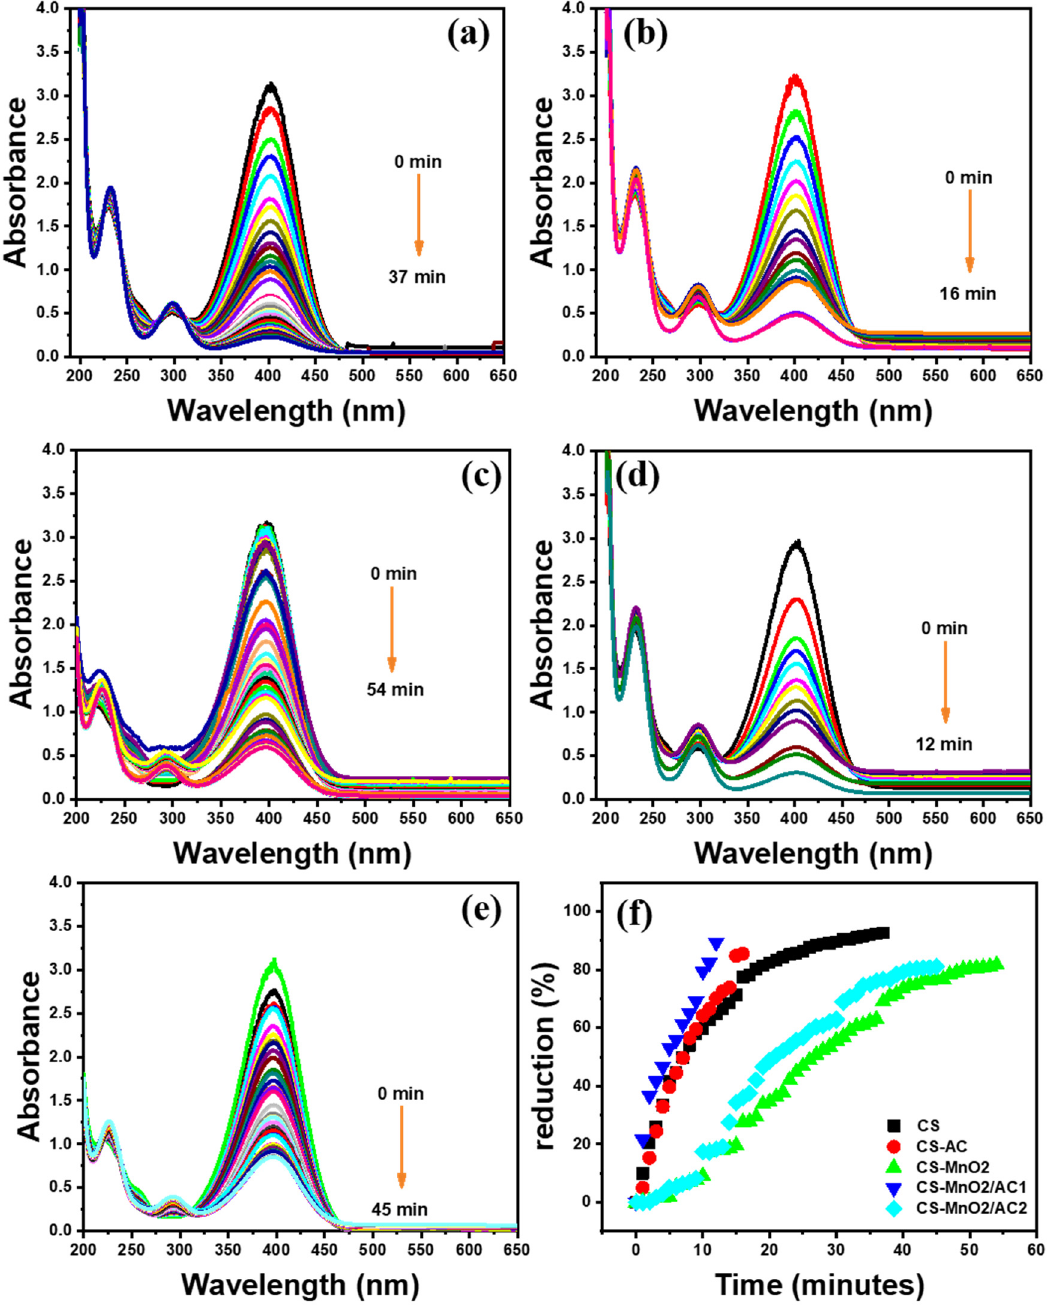
Figure 4. Absorbance spectrum of 4NP reduction in the presence of NaBH 4 by using CS@Co ( a ), CS-AC@Co ( b ), CS-MnO 2 @Co ( c ), CS-MnO 2 /AC1@Co ( d ), CS-MnO 2 /AC2@Co NPs ( e ) and percentage reduction as a function of time ( f ). Experimental conditions: 2.5 mL of 0.2 mM 4NP solution; 0.5 mL of 0.5 mM NaBH 4 solution and 20 mg of each catalyst.